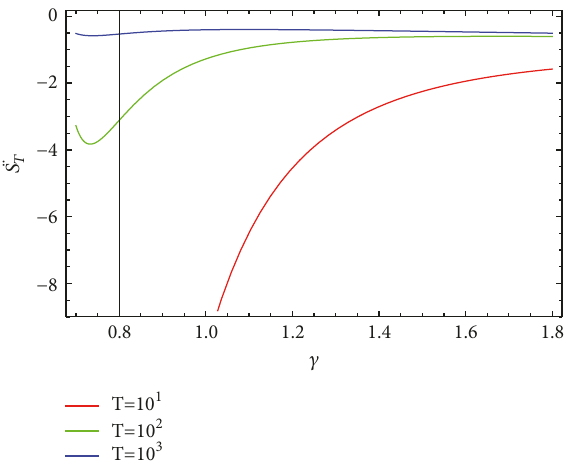
̈𝑆 𝛾 for Bekenstein entropy when Γ = Γ(𝑡) . 𝑇 versus